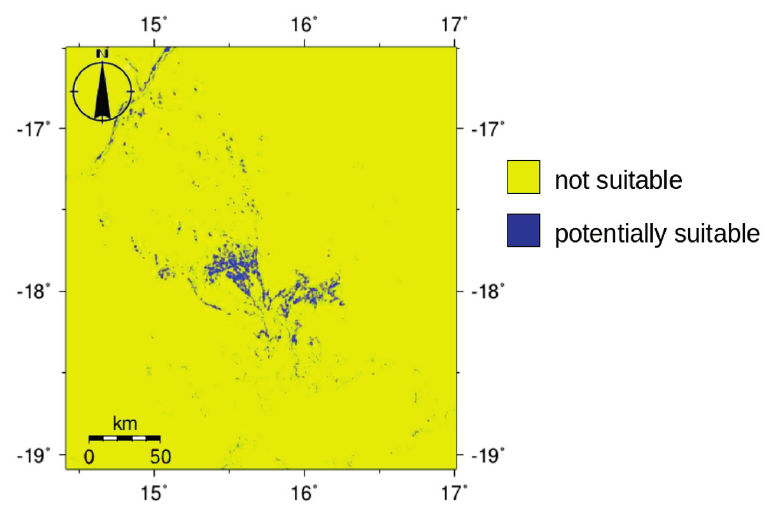
Figure 12. The distribution of the areas potentially suitable for rice